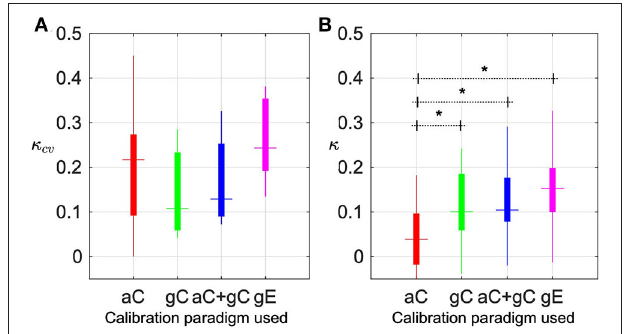
FIGURE 6 | Performance of different calibration paradigms. (A) Box plots present the cross-validation performance, κ cv , across seven sessions, using arrow-based calibration ( aC ), game-based calibration ( gC ) and combined aC + gC and six sessions using game-based evaluation ( gE ). In each box, the horizontal dash indicates median value, the top and bottom edges of the box indicate the 25th and 75th percentiles and the vertical line indicates the range. (B) The boxplots represent online game performances using BCI, calibrated using each of these paradigms. The evaluation is based on four game runs in each of the seven sessions, for aC , gC , and combined aC + gC and six sessions for gE . Columns marked with * imply statistically significant difference ( p < 0.05). FIGURE 7 | BCI performance with recalibration. (A) BCI performance across